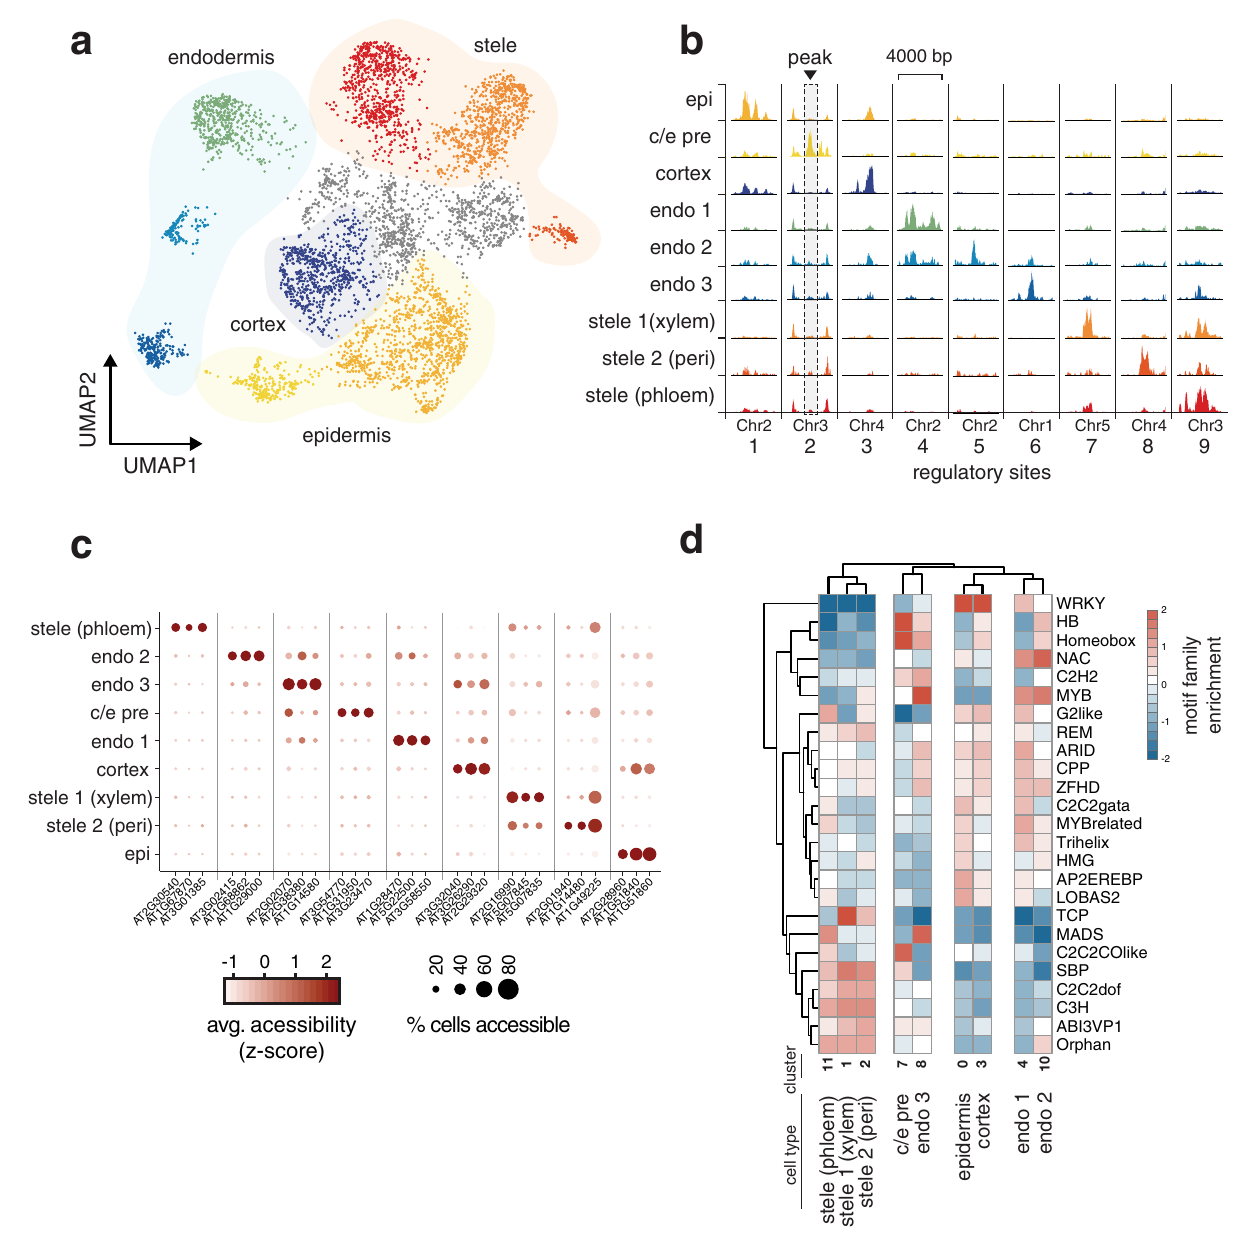
Fig. 1 scATAC-seq identi fi es known root cell types. a UMAP dimensionality reduction plot of root cells using peak-level scATAC data. Cells are colored according to Louvain clusters, and broad tissue types are indicated with transparent shading. b Pseudo-bulked peak tracks generated by combining ATAC data from all cells within a cluster. Each column represents a single locus in the genome that shows cell type-speci fi c accessibility; each row represents a cell type, and each column shows an example marker peak for each type. Colors match those in previous panel. A cluster residing between the epidermis and endodermis clusters, with expression of markers from both cell types (Supplementary Fig. 2B, C) was given the label “ c/e pre ” (precursor of cortex/ endodermis, second row), and epidermis was shortened to “ epi ” . c Dotplot showing marker genes for each cell type cluster. Each column represents a single gene ’ s activity score, the summed accessibility of its gene body and promoter sequence ( − 400bp from transcription start site). The color of each dot indicates the magnitude of accessibility and the size of each dot represents the fraction of cells in each cell type showing accessibility at that gene. d Heatmap showing the predicted effect, across all peaks, of motifs from each Arabidopsis transcription factor family on cell type-speci fi c accessibility. Darker shades of red indicate that presence of the motif is correlated with increased accessibility in that cell type, whereas shades of blue indicate that the motif is anti-correlated with accessibility. The mean effect all transcription factors within a given family are shown as rows, and each column represents a cell type. Source data for UMAP projection and cell annotations ( a ) are provided as a Source Data fi